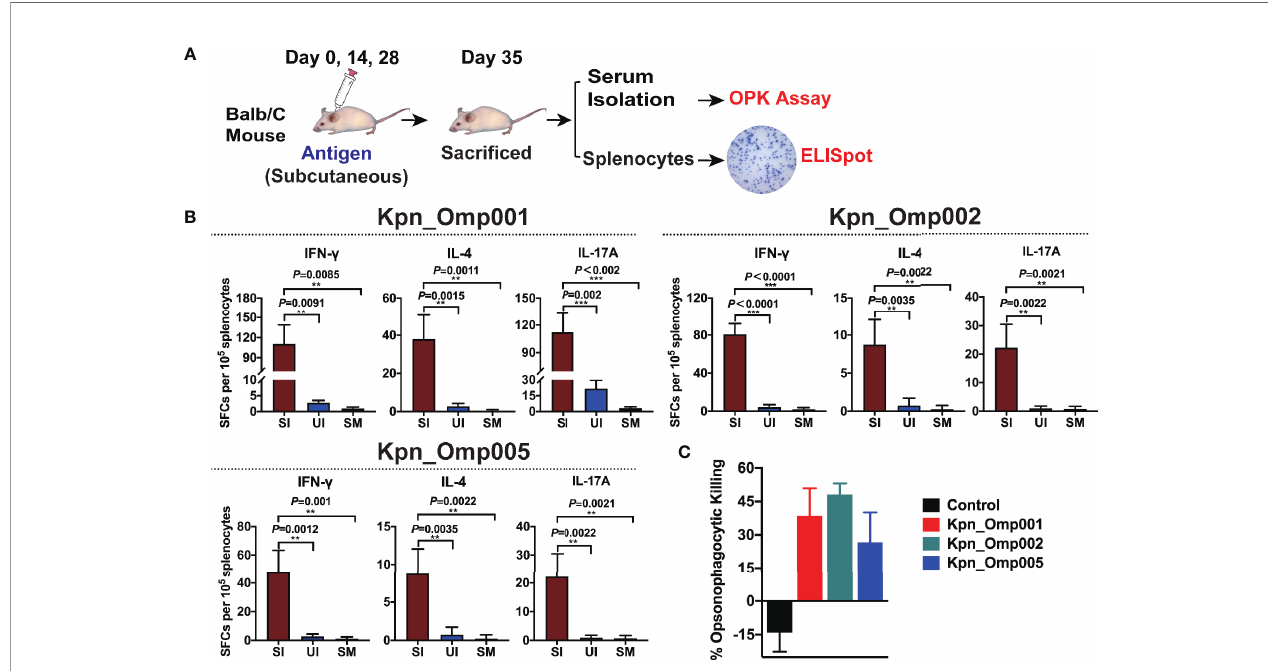
FIGURE 6 | ELISPOT assay and opsonophagocytosis killing assay. (A) Balb/c mice were immunized with the Kpn_Omp001, Kpn_Omp002, and Kpn_Omp005 individually or PBS, and mice were sacri fi ced 7 days after the second booster vaccination. After euthanasia, spleens were collected and a single suspension of splenocytes was obtained for cytokine-speci fi c enzyme-linked Immunospot assay (ELISPOT assay), and the serum was isolated for the opsonophagocytosis killing assay. (B) Interferon gamma (IFN- g ), interleukin 4 (IL-4), and interleukin 17A (IL-17A)-producing splenocytes from vaccinated or control mice were analyzed using ELISPOT assay. SI: Immunized mice stimulated with KOMP, UI: Unstimulated immunized mice, SM: Mock mice stimulated with KOMP. (C) The opsonophagocytosis killing assay. The bacteria were incubated with heat-activated mouse antiserum against different KOMPs at 4°C for 20 min, differentiated HL-60 cells and rabbit complement co-incubated at 37°C for 1 h with agitation at 600 rpm, and samples were plated on BHI agar plates for CFU enumeration. **p < 0.01, ***p <